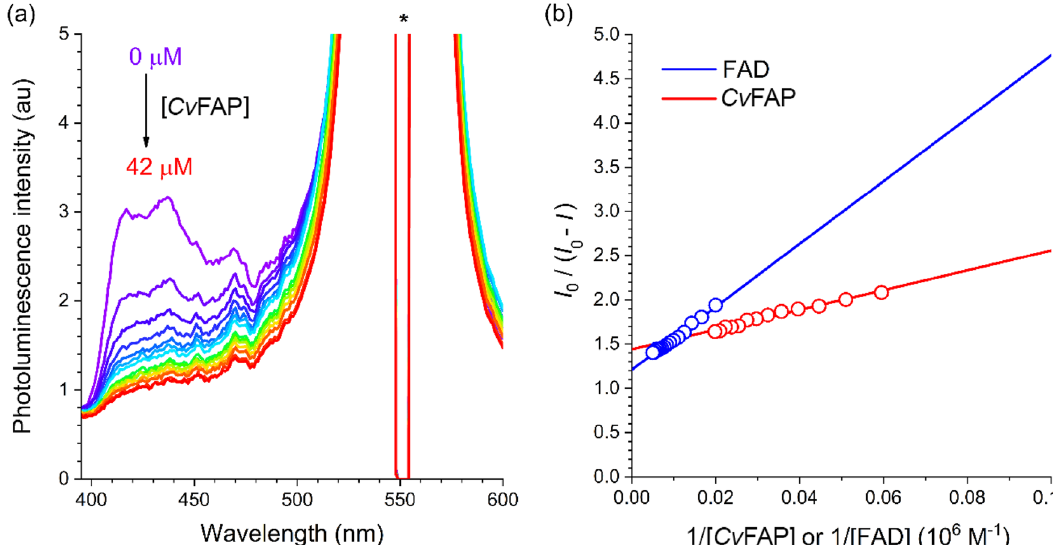
Figure 3. Photoactivation of a flavin-dependent photodecarboxylase. ( a ) Fluorescence titration results for the PtOEP:DPA@PS nanoparticle suspension (milli-Q water) recorded with increasing the concentration of a flavin-